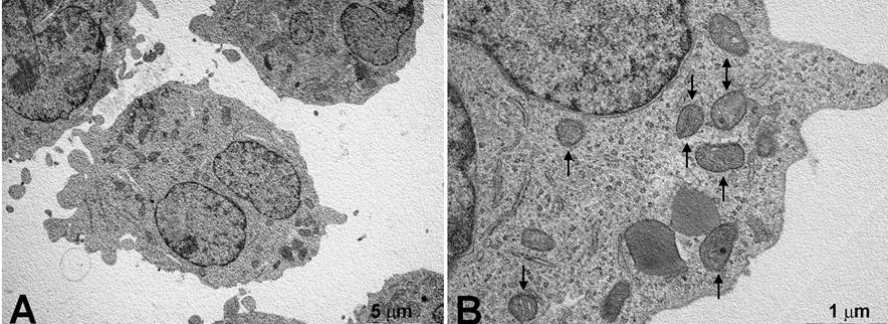
Figure 5. Control K562 cells. ( A ) The cells show a normal ultrastructure. ( B ) Numerous mitochondria (arrows) rich in cristae and with dense inner matrix-as usual in normally functioning organelles-can be seen in the cytoplasm.